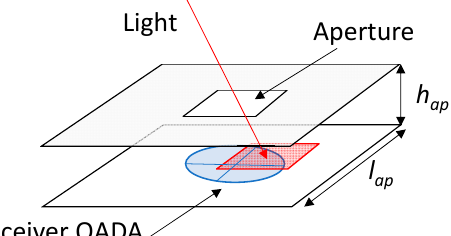
Figure 4. Geometrical representation of the quadrature angular diversity aperture (QADA) receiver.